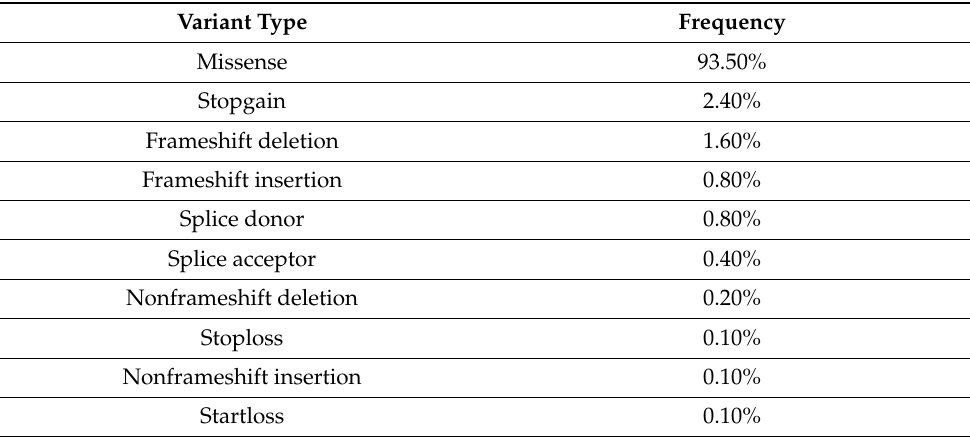
Table 1. Distribution of the selected variant types present in the cohort.